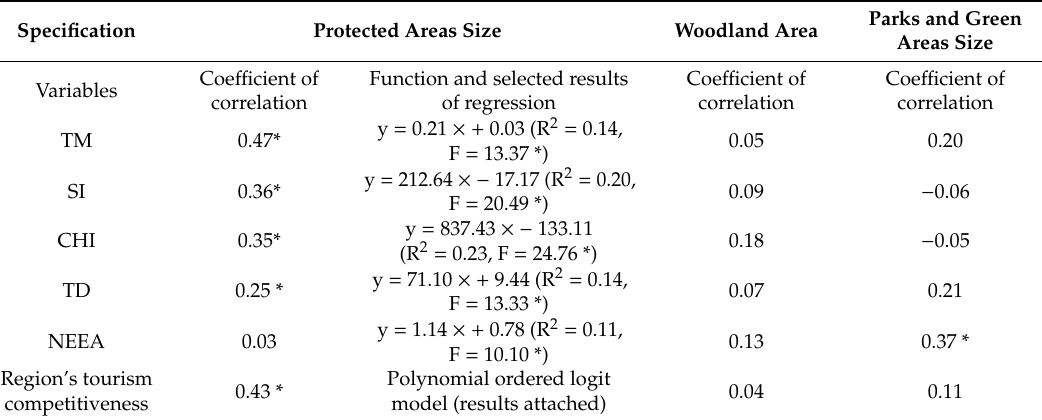
Table 6. Results of Pearson correlation and